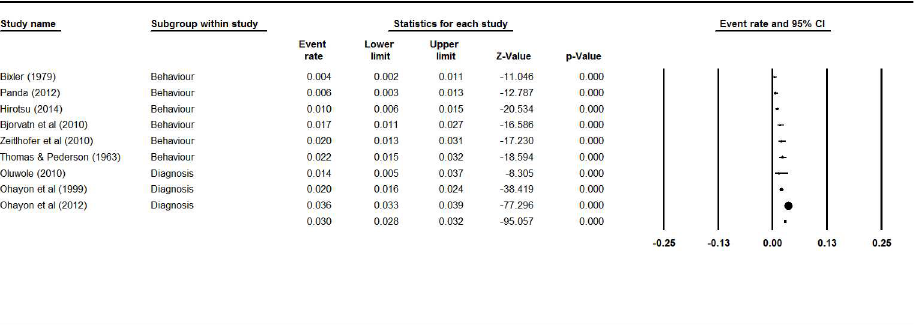
Fig 3. Forest plot for Current Sleepwalking in